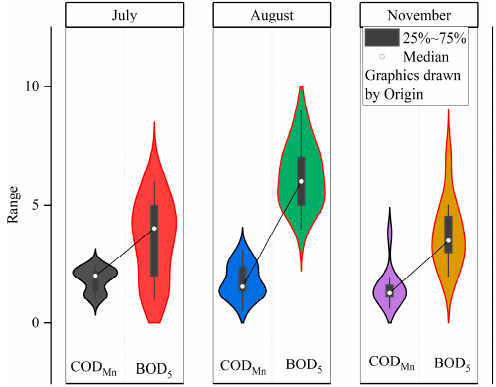
BOD 5 : five days biological oxygen demand.3.1.3. Nutrients. the Maotiao River Basin (Gizhou province, SW China) in 2020. COD Mn : chemical oxygen demand;